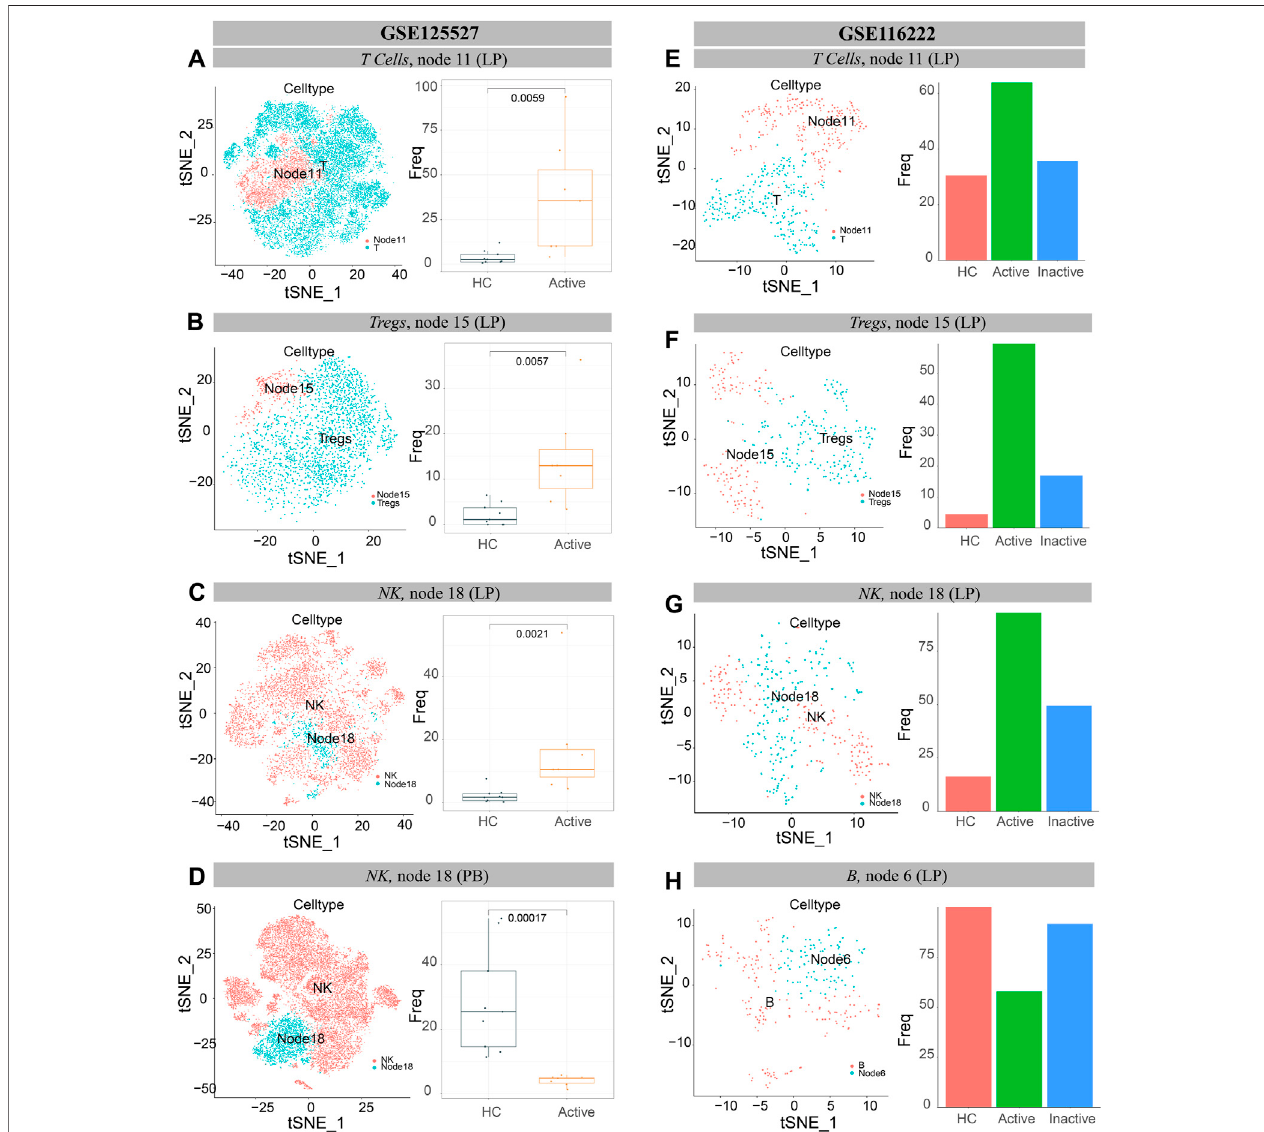
FIGURE 8 | Veri fi cation of single cells derived from UC and healthy samples. (A – D) t-SNE plots of T lymphocytes (A) , Tregs cells (B) and NK cells (C,D) from all participants across mucosa (LP) and peripheral blood (PB) in GSE125527. “ Node ” labels in the t-SNE plots indicate the same subclusters as the nodes in CyTOF, and the labels “ T ” (A) , “ Tregs ” (B) and “ NK ” (C,D) indicate individual cell populations (left). Boxplot of the selected T lymphocyte (A) , Treg cell (B) and NK cell (C,D) cluster abundancesinmucosa(LP)andperipheralblood(PB)samplesofHCsandUCapatients(right),withWilcoxonrank-sumtestresults;statisticalsigni fi cancewasset at p < 0.05. (E – H) t-SNE plots of T lymphocytes (E) , Treg cells (F) , NK cells (G) and B cells (H) from all participants ’ mucosa (LP) in GSE116222. “ Node ” labels indicate subclusters with nodes in CyTOF, and “ T ” (E) , “ Tregs ” (F) , “ NK ” (G) and “ B ” (H) labels indicate respective cell populations (left). Bar charts of the selected T lymphocyte (E) , Treg cell (F) , NK cell (G) and B cell (H) cluster abundances in mucosa (LP) samples of HCs, UCa patients and UCin patients